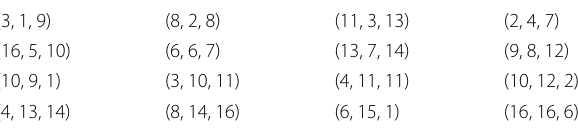
Table 2 Node coordination of optimized 3D